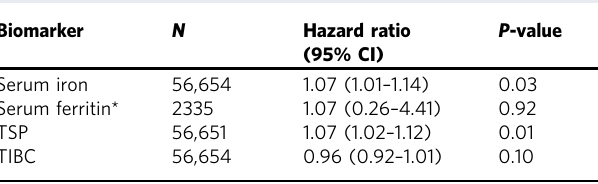
Table 3 Linear Mendelian randomization ratio of coef fi cient